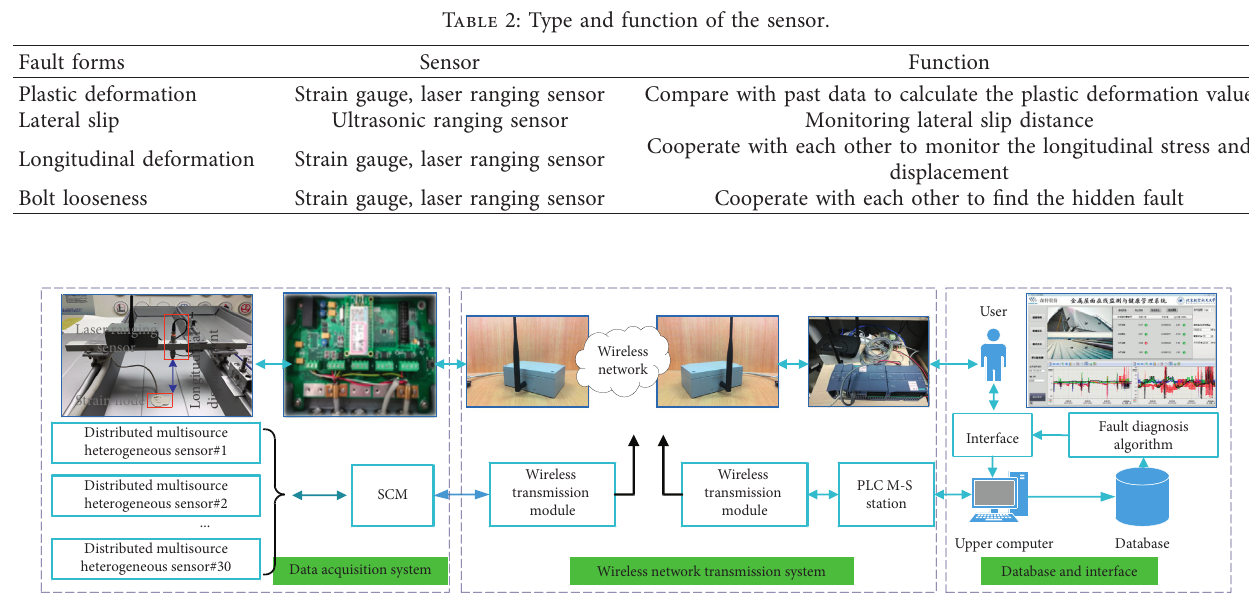
Figure 5: Structure diagram of whole system.